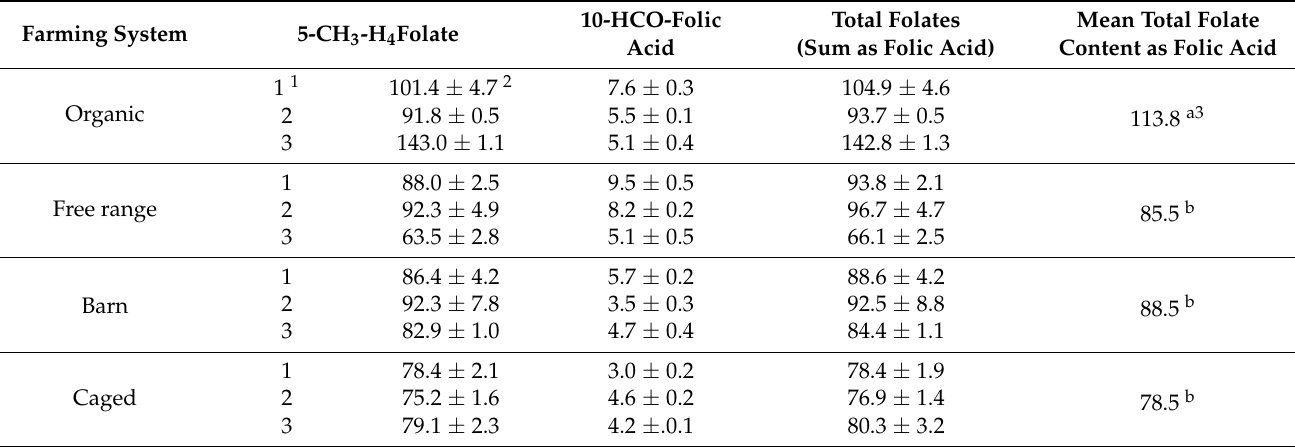
Table 1. Folate content in raw hen eggs from different farming systems ( µ g/100 g FW). Farming